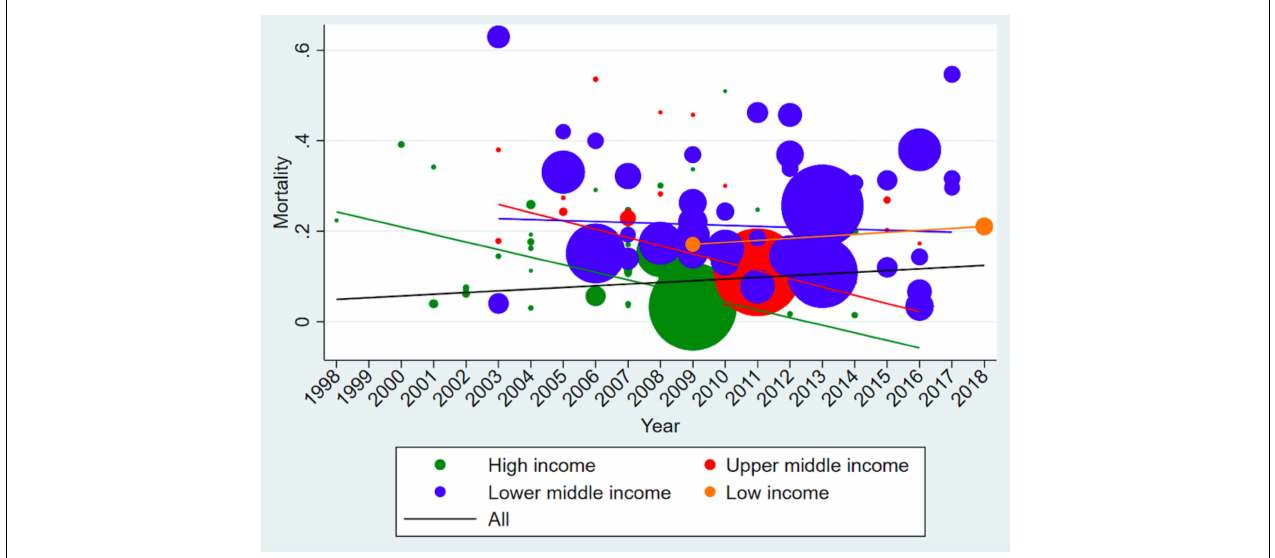
FIGURE 5 | Time trend analysis of Case Fatality Rates (including only low risk of bias studies). The size of the bubble is proportionate to the number of infants in the study, while the line represents the trends of case fatality rates over time. There is an increasing trend for low-income countries and decreasing trend for middle- and high-income countries overtime. The overall trend for young infant sepsis case fatality rates is increasing.